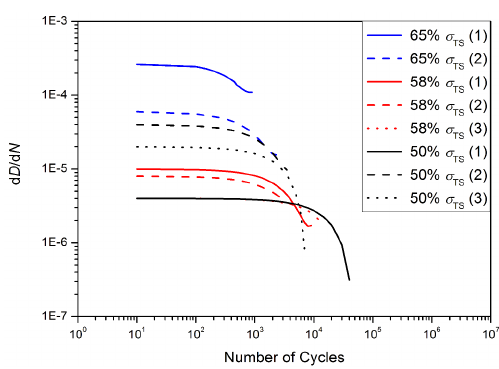
Figure 23. The damage rate in C-SMC-Cut-35 as a function of the number of cycles. Representatively, in the case of 65% σ TS (1) of C-SMC, A ( D ) was 0.022 D 2 − 0.0035 D + 0.003 and B (slope) was − 0.045 according to d D /d N . Based on the elastic modulus degradation